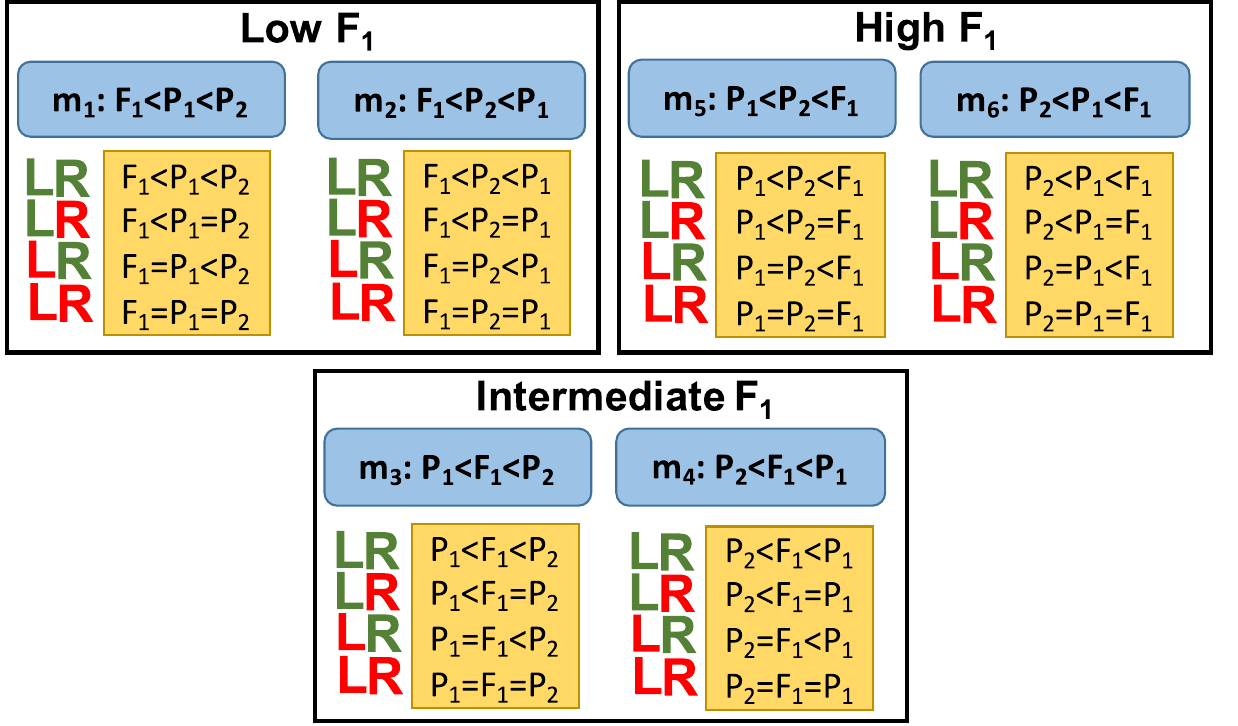
Figure 1. Inheritance class, model and sub-model. Inheritance classes are presented in main rectangles (Low F 1 , Intermediate F 1 and High F 1 ); models ( m 1 to m 6 ) are presented in blue rectangles within each class and sub- models are presented in the orange rectangles below each model. Adjacent to orange rectangle the symbols “ L ” and “ R ” represent the left and right hand side inequality of the corresponding model ( m i ). In those letters, green means that the corresponding inequality stands, while red means that the inequality is substituted by equality. The final result of each row (sub-model) is shown in the orange rectangle.